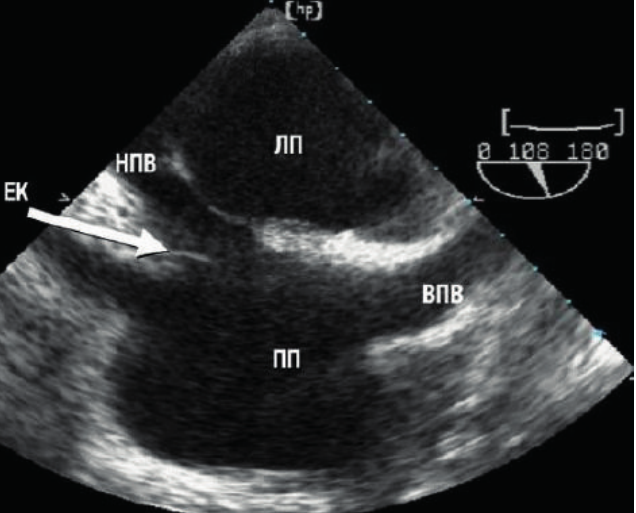
(thrombus), sizes 3,35х5,07х3,67, arising from IVC, have prolapse in the cavity of left athrium. IVC is dilated till 1,6